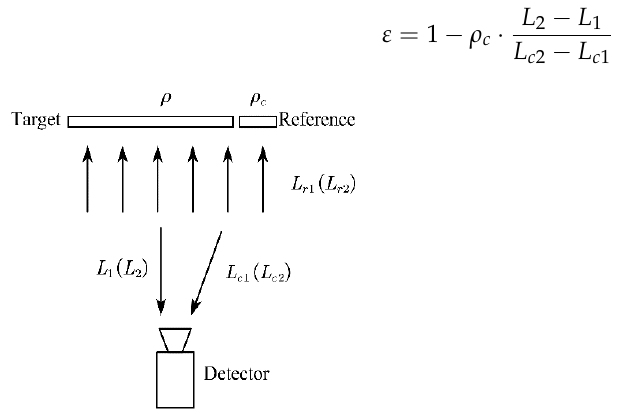
Figure 2. Schematic diagram of introducing a reference body in the measurement.